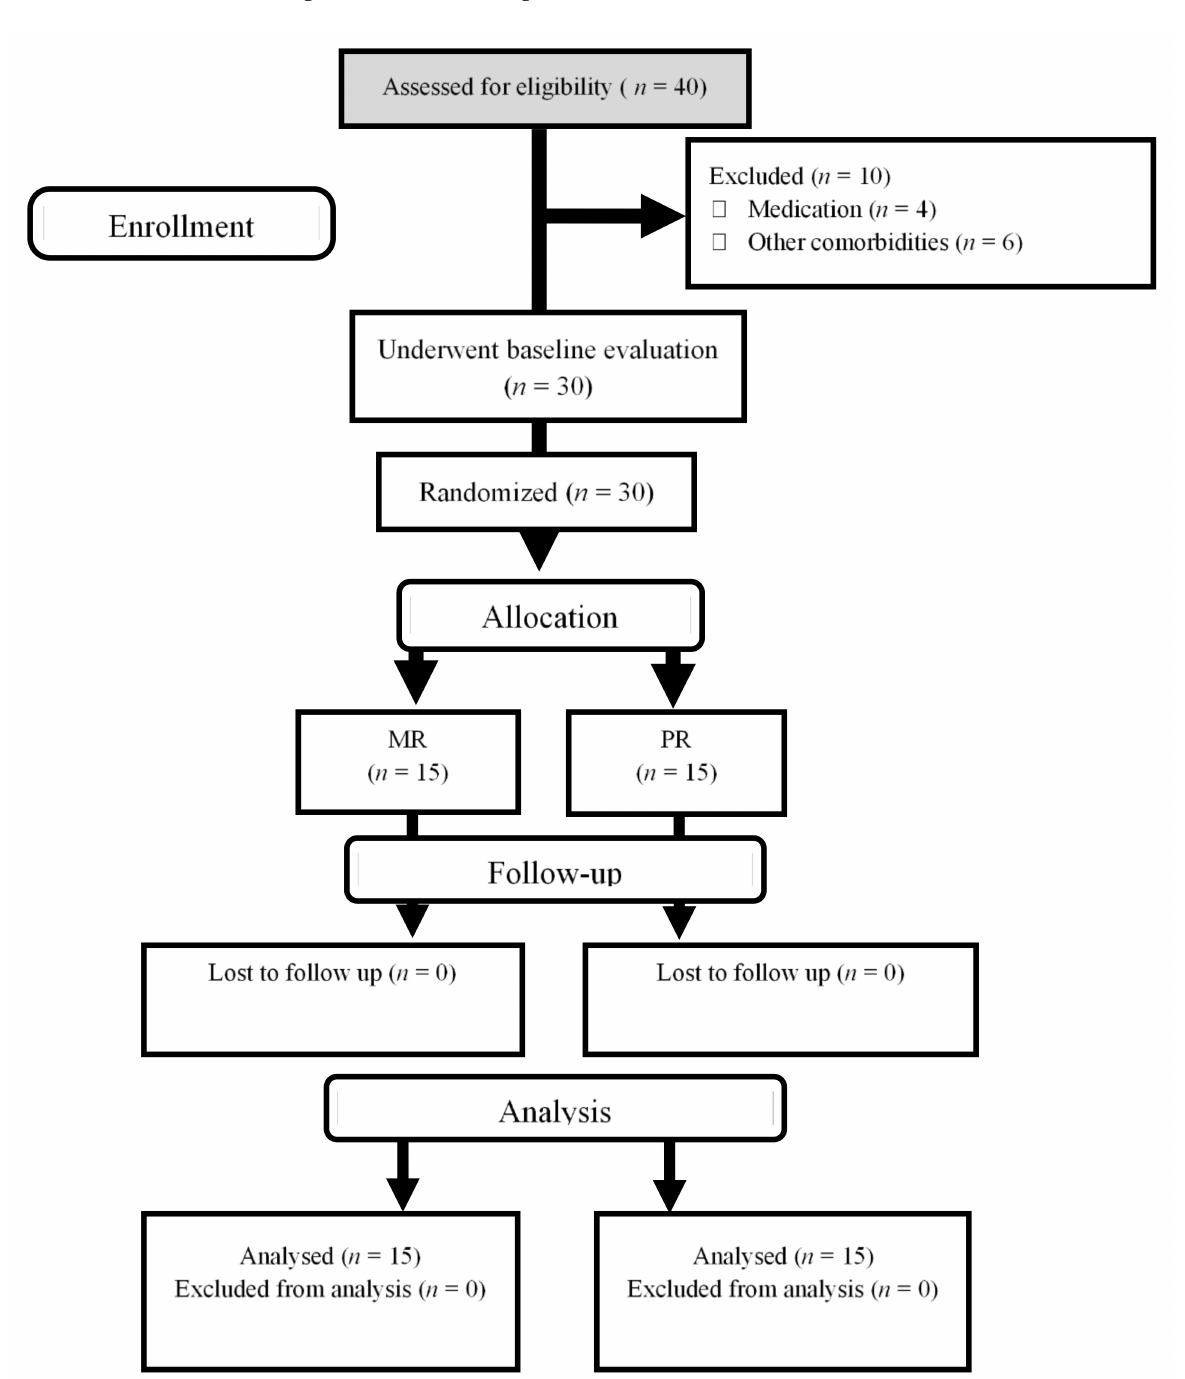
Figure 1. Flow diagram of study